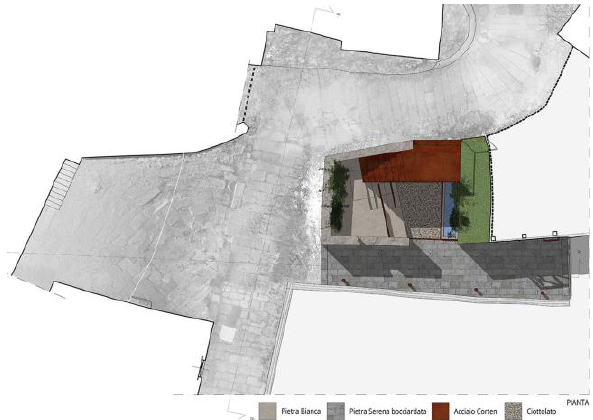
Figure 6. Plan of the project created by the seminar students.